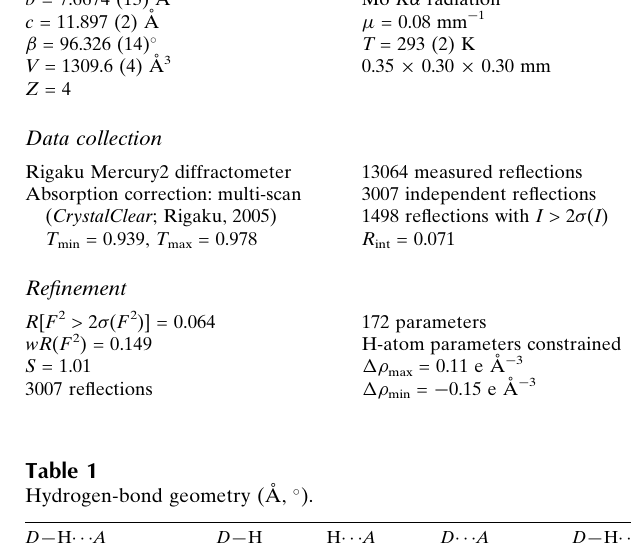
Rigaku Mercury2 diffractometer Absorption correction: